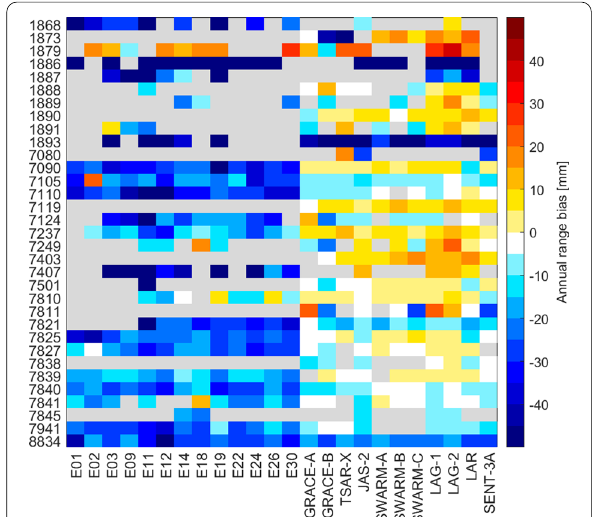
Fig. 5 Annual average range biases for selected SLR station–satellite pairs in 2016 (E01–E30 names refer to Galileo PRNs). Gray area means no